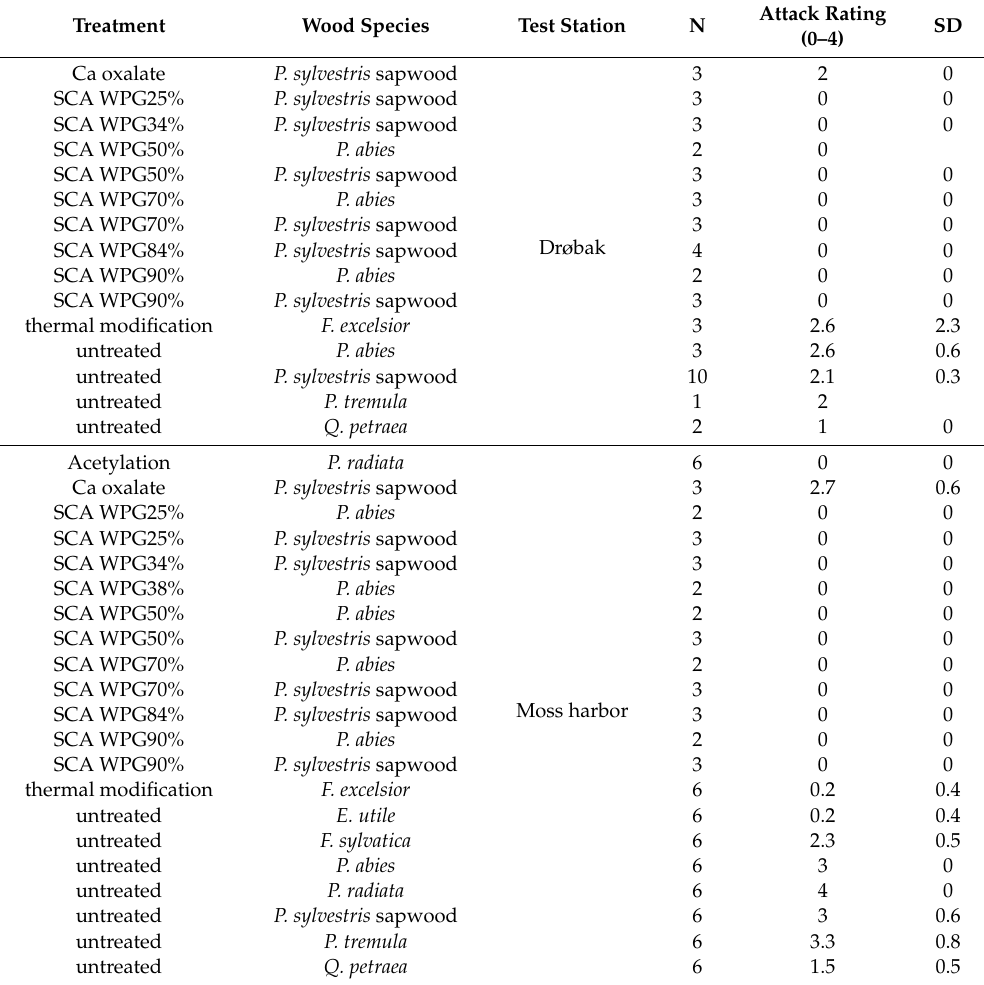
Table 4. Attack rating after 4 months of wood borer attack (shipworm) in treated and untreated control wood species in Drøbak and Moss harbor.